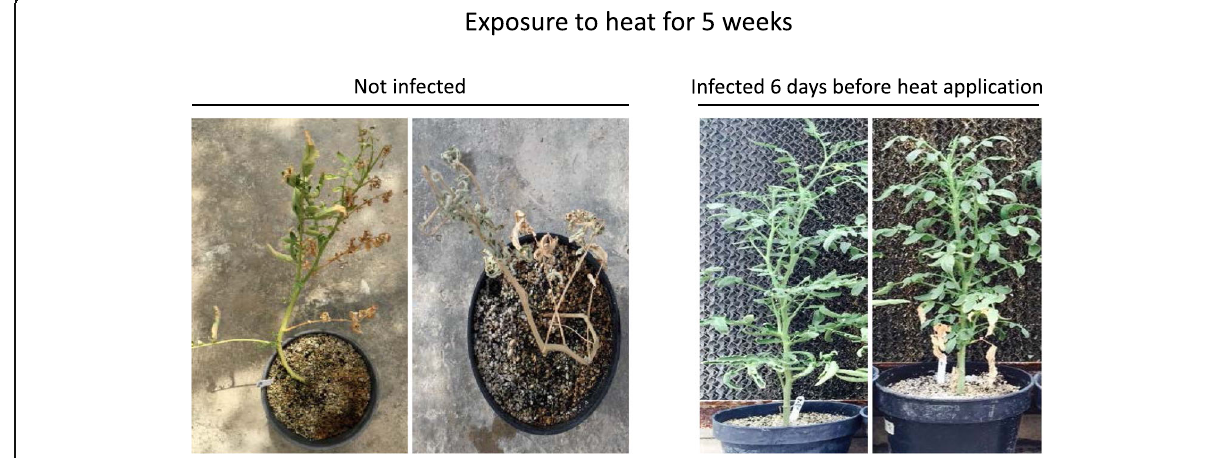
Fig. 2 Growth of resistant tomatoes under heat conditions. Un-infected (two different plants grown simultaneously) and pre-infected (6 dpi) (two different plants simultaneously) R-GF967 tomatoes were grown in greenhouse without cooling during five weeks when temperatures reached 50 °C – 52 °C. The photos, taken at the same time (35 days after heat exposure), demonstrate the survival efficiency of tomatoes containing